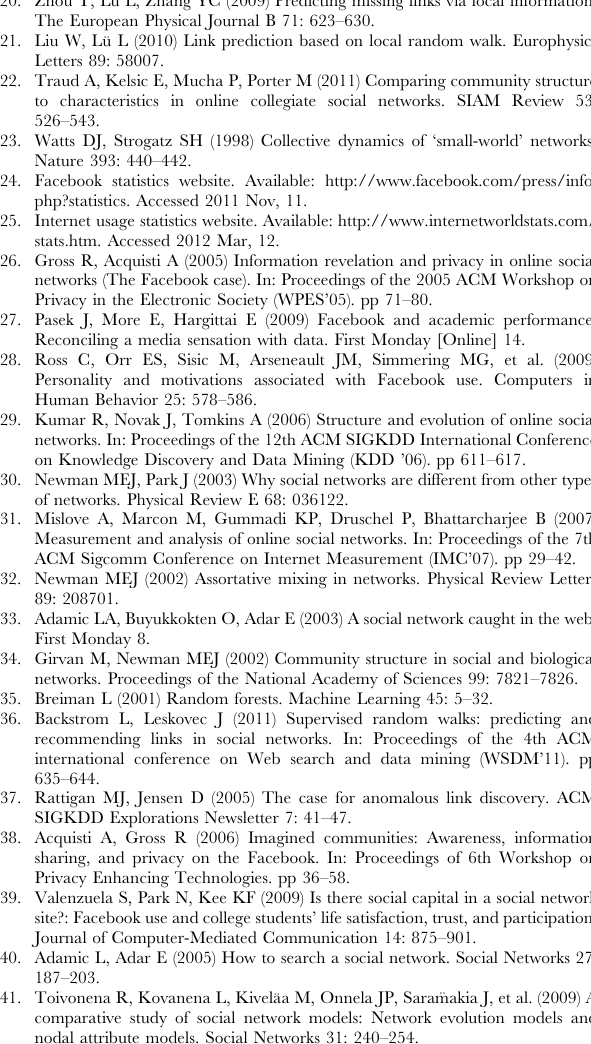
Text S2 Details regarding feature extraction. (PDF) Text S3 More information on the learning procedure with random